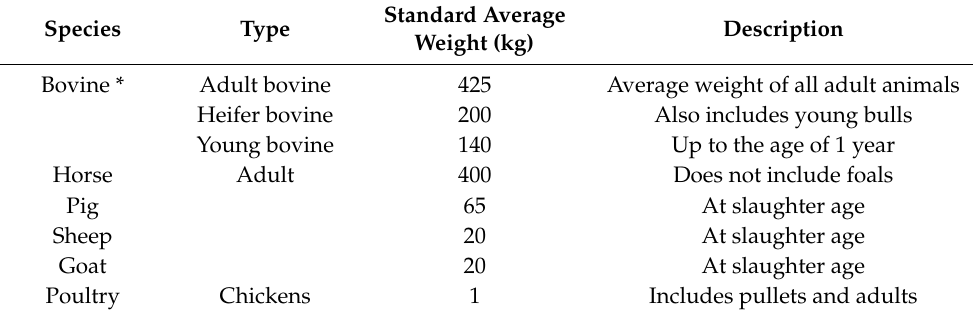
Table 1. Standardised average weights of different livestock species. Species